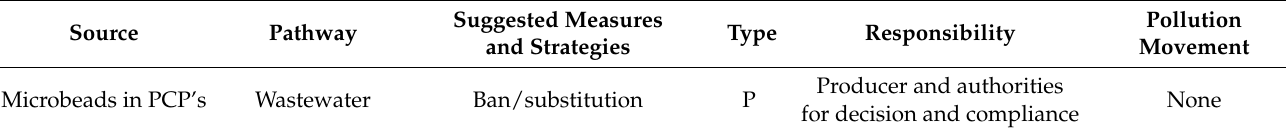
Table 1. Sources of MP pollution and examples of suggested strategies (adapted from [10], with modifications); type: Pre- ventative (P) → e.g., legislation or behavioral change, decentralized treatment (D) → at the source or in the urban area, centralized treatment (C) → at the